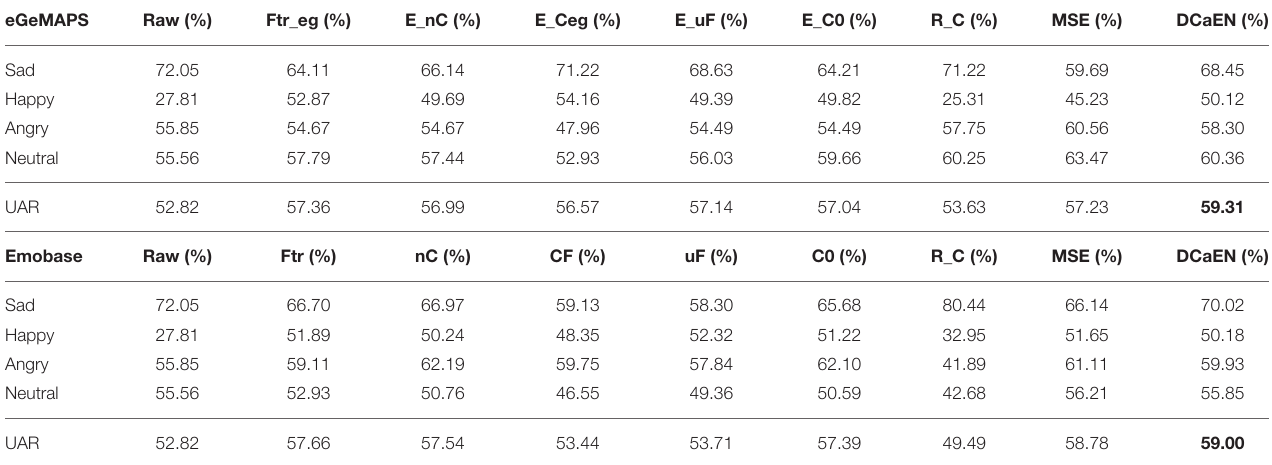
TABLE 2 | Comparing performances of emotion recognition for different models on the IEMOCAP.